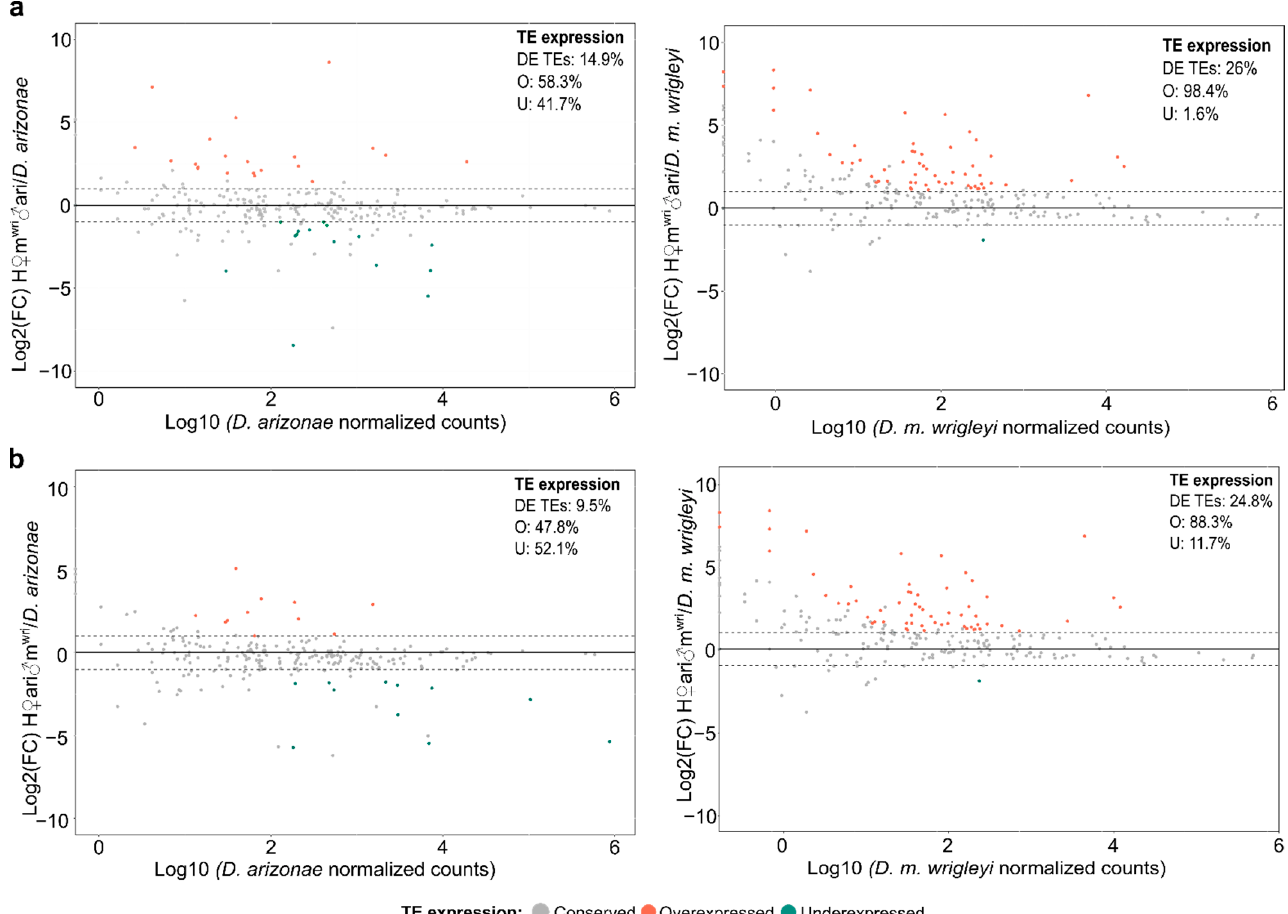
Figure 3. TE expression in ovaries of hybrids vs. parental lines. ( a ) log2 of the ratio (counts in H ♀ m wri ♂ ari/counts in parental lines ( D. arizonae and D. m. wrigleyi )); ( b ) log2 of the ratio (counts in H ♀ ari ♂ m wri /counts in parental lines ( D. arizonae and D. m. wrigleyi )). Dotted lines represent Log2(FoldChange) > |1| and p -value adjusted < 0.05. DE TEs: deregulated TEs; O: overexpressed TEs; U: underexpressed TEs.